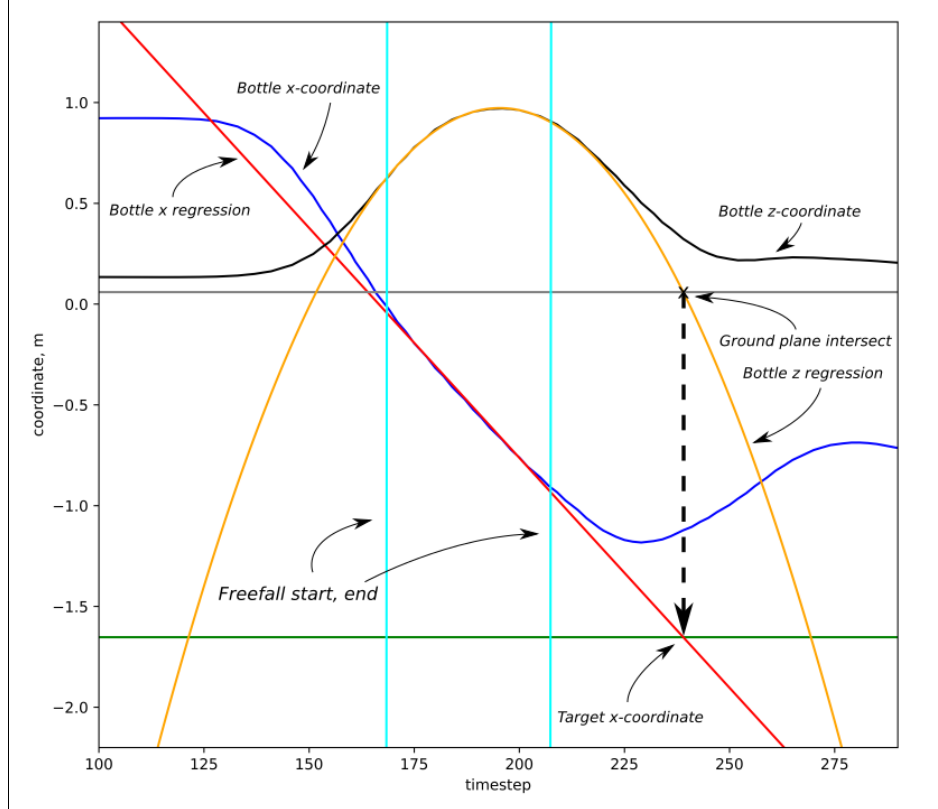
Figure 4. Estimation of the throw target coordinates. Bottle position data are used to annotate each demonstration—consisting of effector pose observations—with throw target coordinates. Regression on the z -axis is used to find the ground plane intersection time, at which extrapolated x - and y - coordinate values are found.